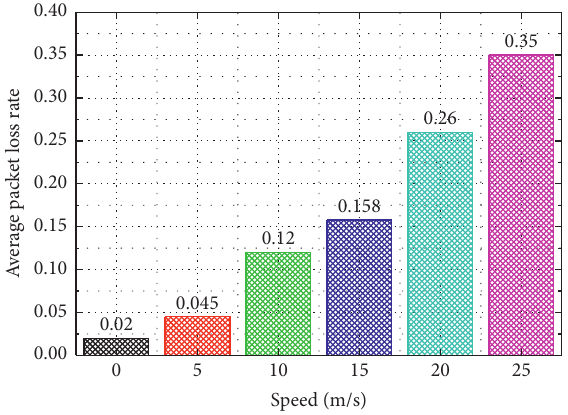
Figure 4: Total packet loss rate at different speeds.